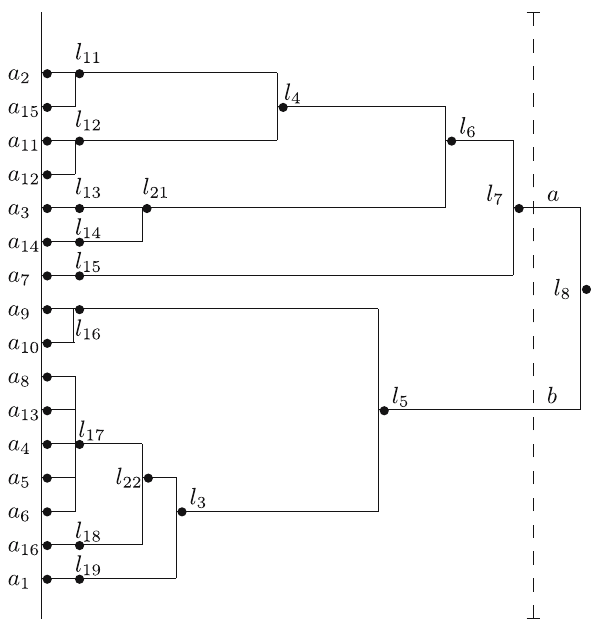
Figure 1: Some expressions of our idea assisted by FIgure 1 in [ 22 ]